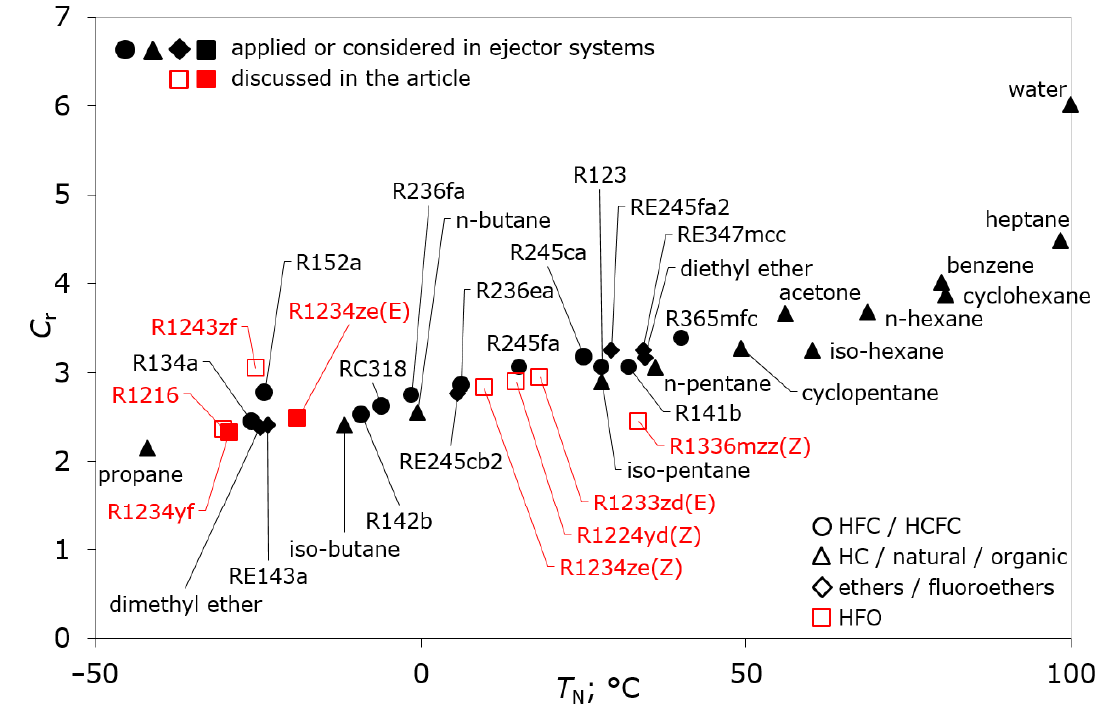
Figure 7. Compression ratio of the selected refrigerants.